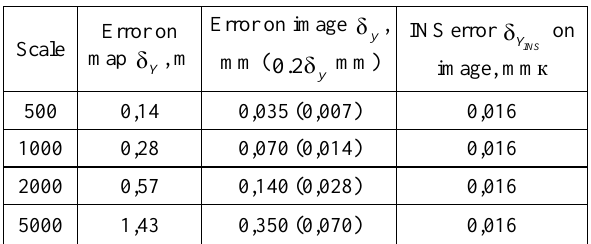
Table 3. Comparative analysis of calculated and acceptable INS errors (axis Y)